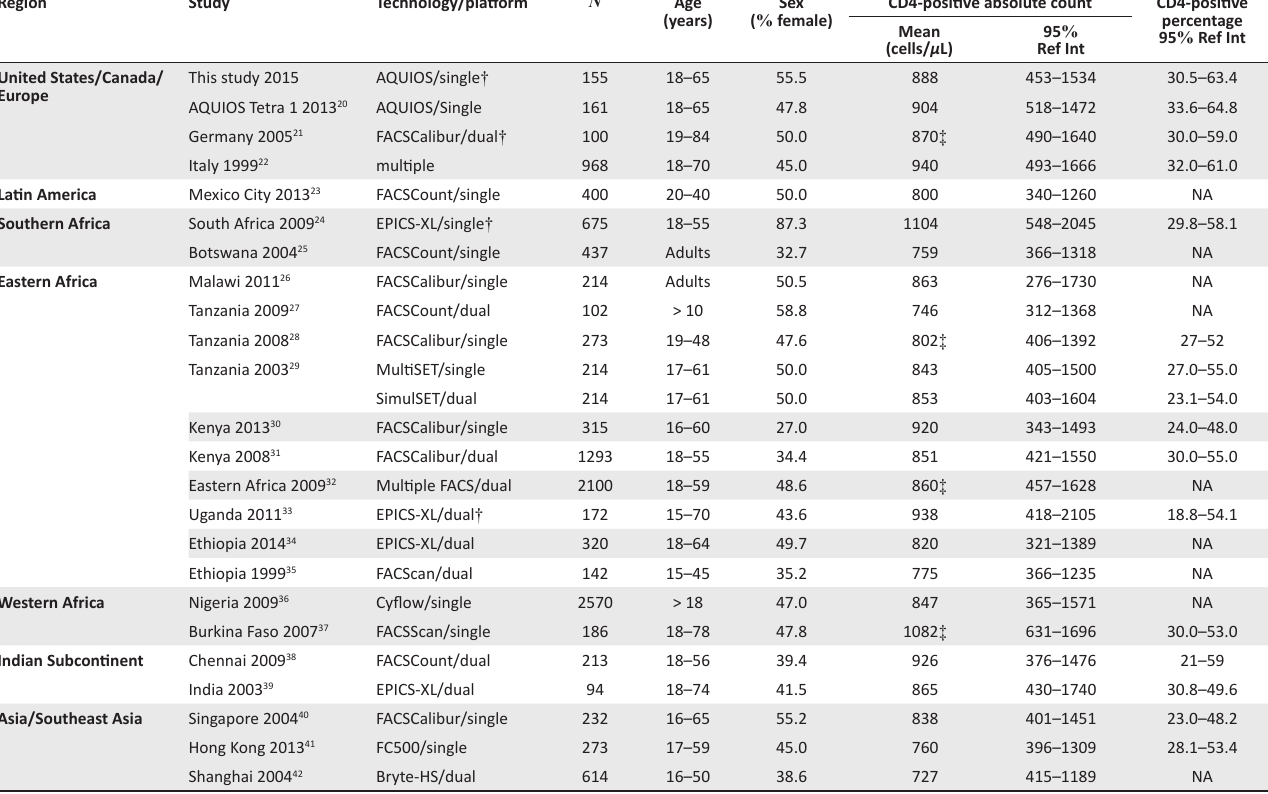
TABLE 4: 95 % reference interval (2.5th – 97.5th) for apparently healthy adults, Canada; Paris, France; and United States, December 2014 to February 2015. Overall Lower reference interval Upper reference interval CD4, cluster of differentiation TABLE 5: Comparison of overall normal reference intervals (2.5th – 97.5th) for CD4 lymphocytes in HIV-negative adults, Canada; Paris, France; Lyon, France; and South Africa, November 2014 to March 2015. Region